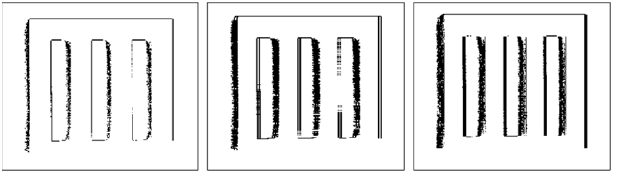
Figure 11. Linear motion parallel to the image plane of the ToF sensor without motion ( left ), with synthetic motion blur ( middle ), and with real linear motion blur ( right ).